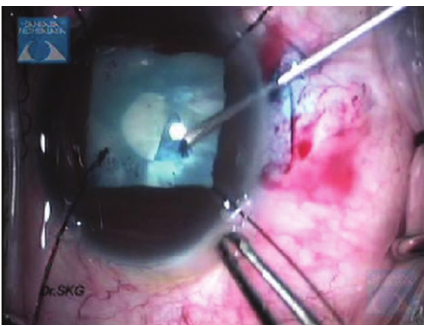
Figure 8: Intraoperative still video clip demonstrating the step of